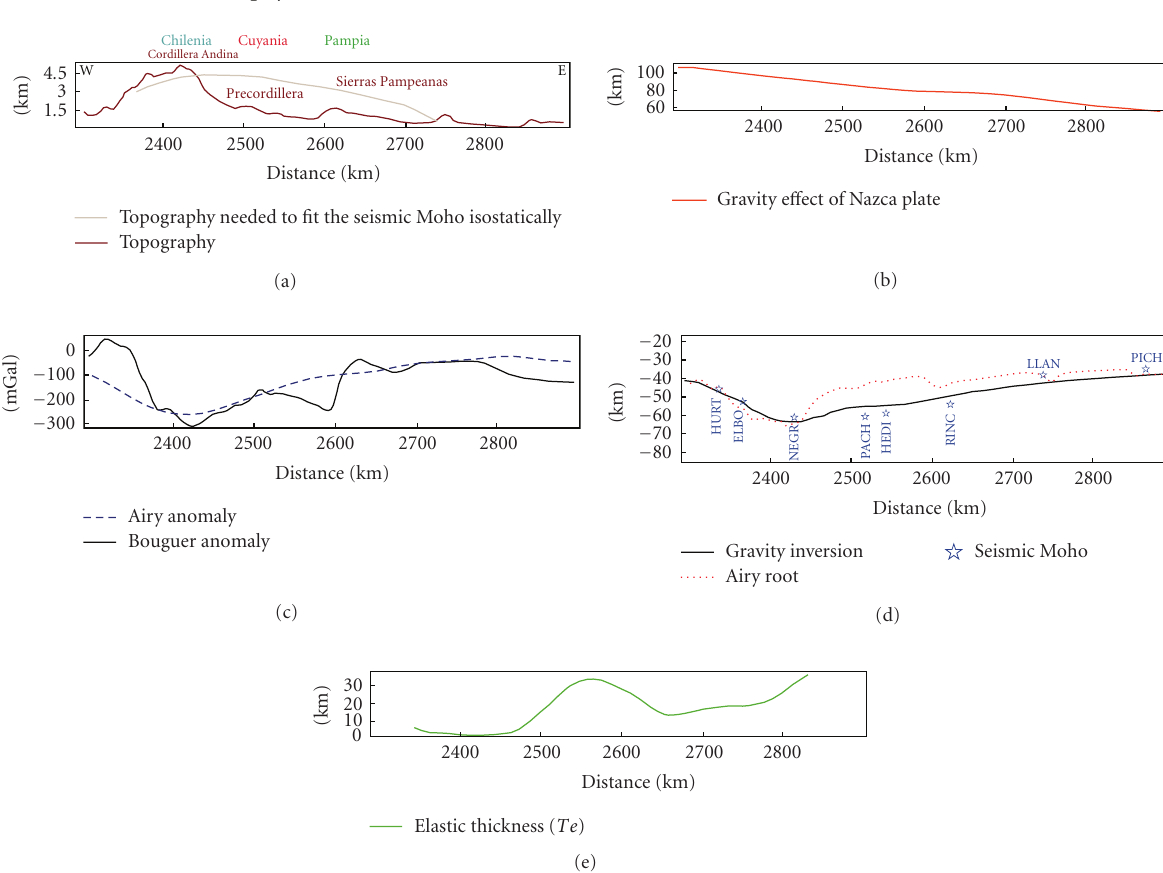
Figure 3: East-west section between latitudes 30 o and 31 o south, coincident with the CHARGE project seismic stations, with the results of the gravimetric and seismic modeling. (a) The present day topographic elevation (brown) and the elevation predicted from the seismic Moho (grey). (b) The gravimetric e ff ect of the Nazca plate (red) calculated from the Grow and Bowin densities [14]. (c) The gravimetric Bouguer anomaly corrected for the gravimetric e ff ect of the Nazca plate and the gravity e ff ect of the Airy isostatic root. (d) The gravimetric inversion (full black line), the isostatic roots (red dotted line), and the seismic depths obtained from Fromm et al. [12] are represented by blue colored diamonds. (e) The e ff ective elastic thickness calculated according to Braitenberg et al. [50], Wienecke et al.